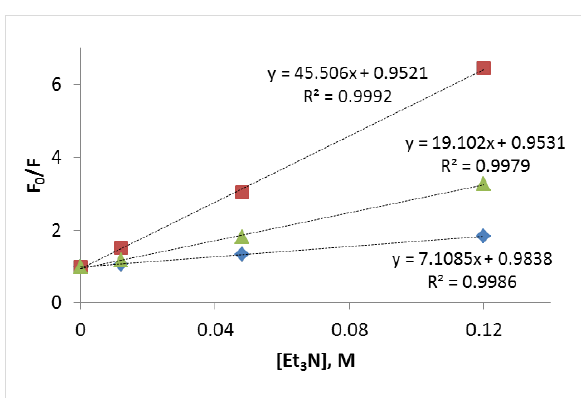
Figure 5: Stern–Volmer plots of three regioisomers, 3 (blue diamond), 4 (red square), and 5 (green triangle), in acetonitrile (10 μ M). The solu- tions were excited at 310 nm.